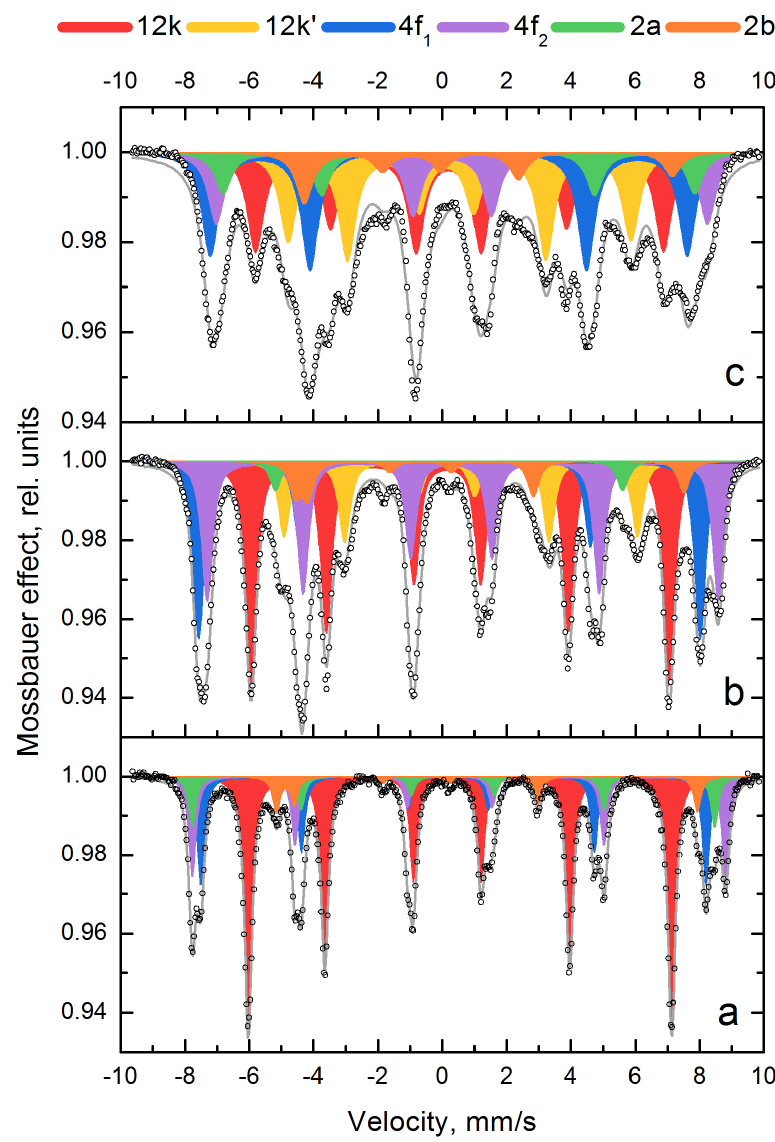
Figure 3. Mössbauer spectra of SrFe 12 − x In x O 19 samples after mechanochemical synthesis and an- nealing at 1200 °C, 1 h with different degrees of Indium alloying: x = 0 ( a ); x = 0.5 ( b ); x = 1.0 ( c ). Circle – experimental data, grey line – calculated data.